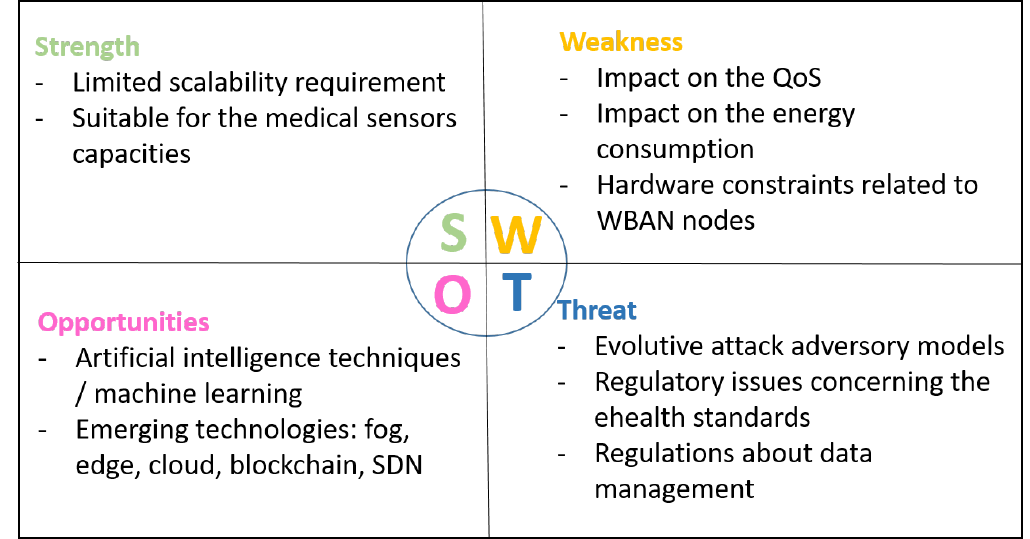
Figure 8. SWOT diagram for WBAN trust